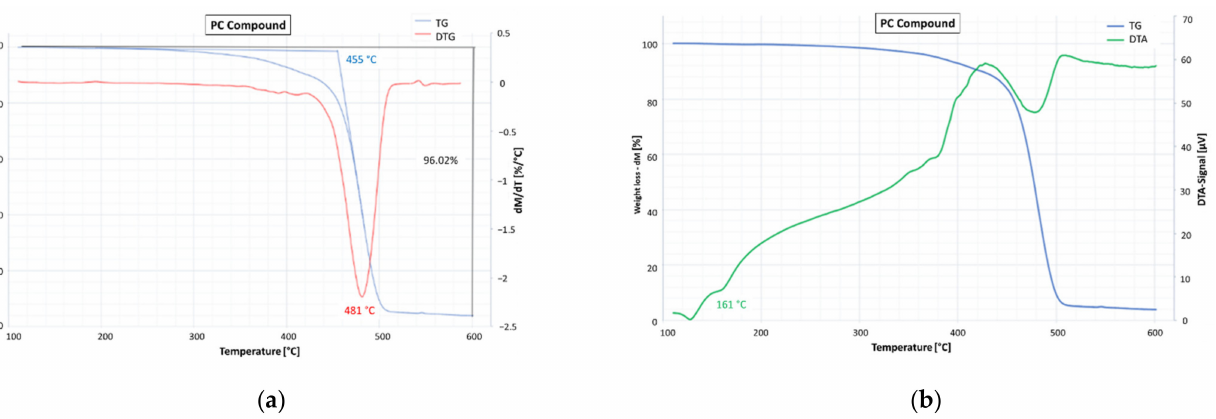
Figure 4. PC compound: ( a ) percentage mass loss TG (blue line) and first derivate of mass loss DTG (red line); ( b ) TG (blue line) and differential thermal profile DTA (green